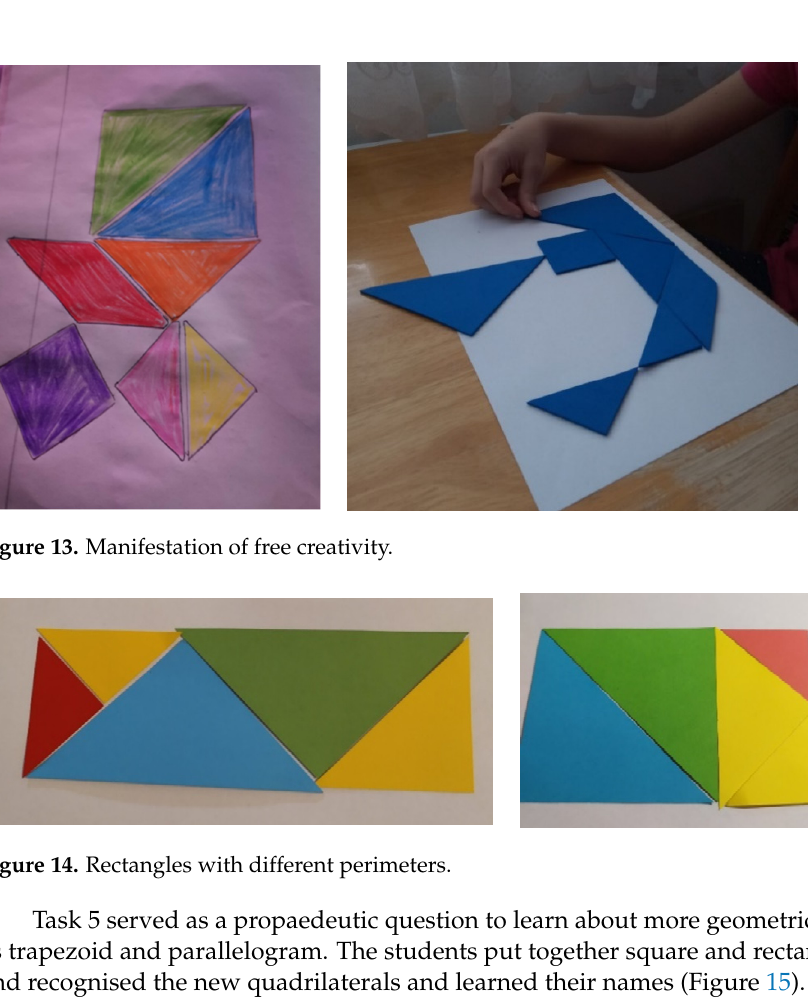
Figure 14. Rectangles with different perimeters.